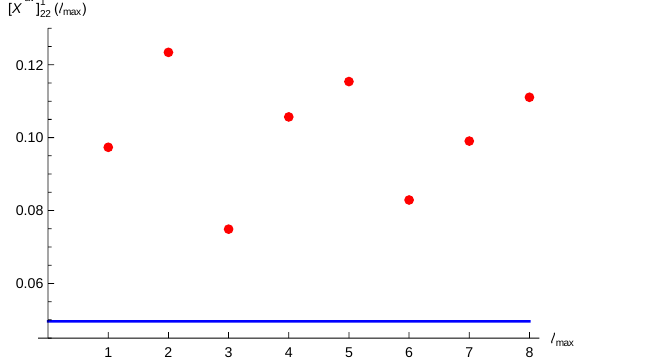
(cid:2) ~X av (cid:3) 1 Figure 11 . Red dots show ( ‘ max ) in the range [0 : 045 ; 0 : 130] plotted against ‘ max . Blue 22 horizontal line at 0 : 0496063 represents the KZ